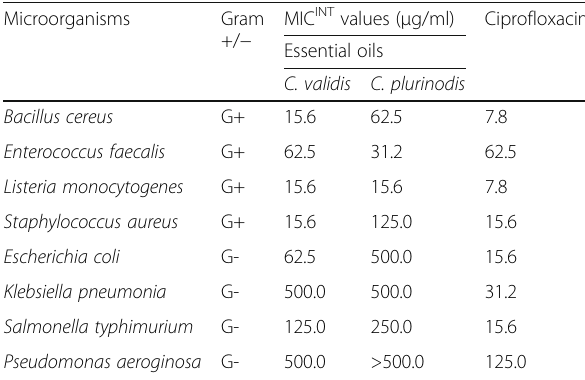
Table 4 Antibacterial activity of Cympbopogon validis and Cymbopogon plurinodis essential oils